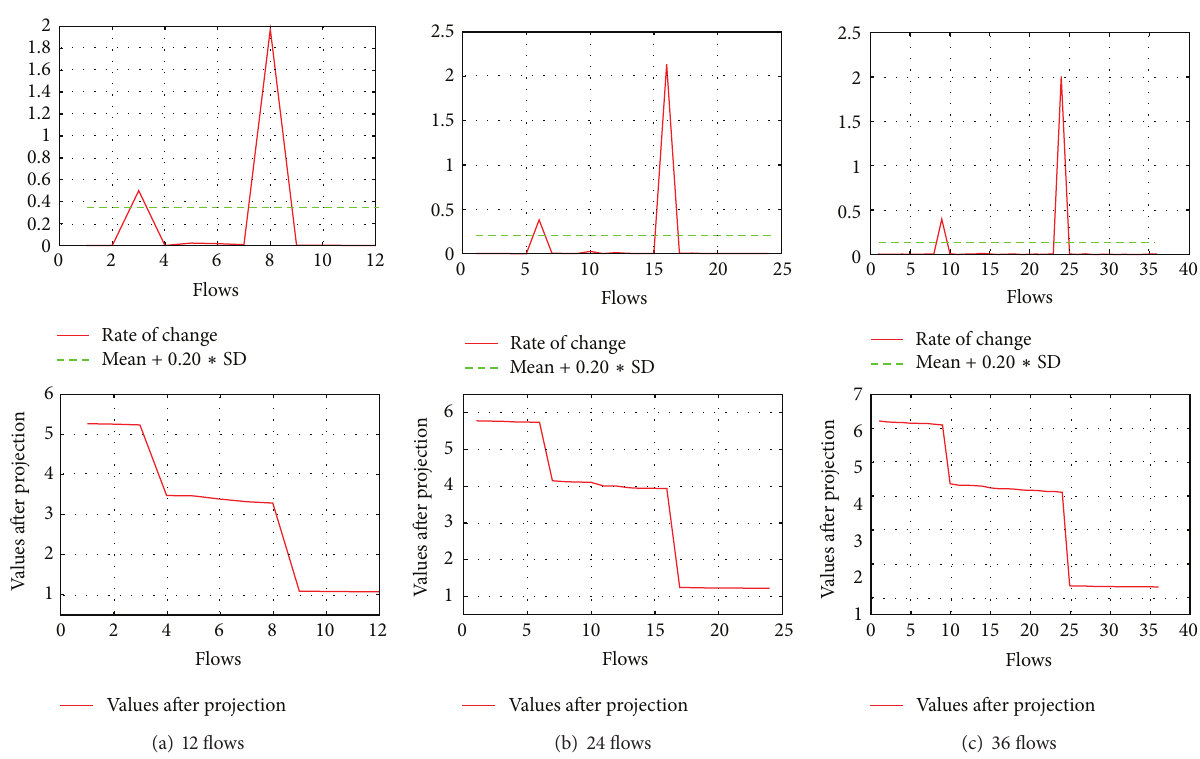
Figure 4: Results of asymmetric topology with varying number of